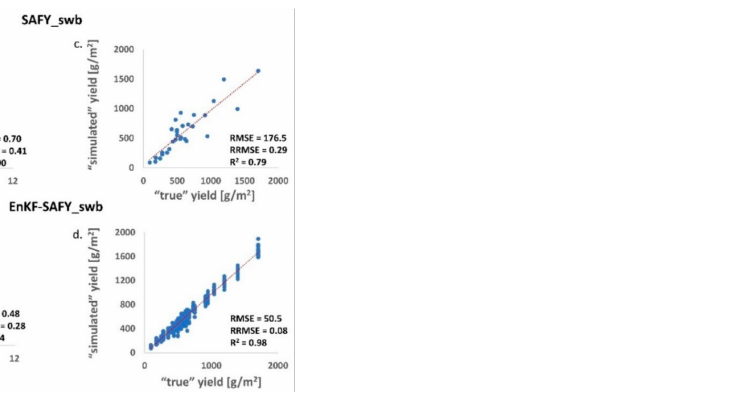
Figure 6. Comparison between “true” and “simulated” variables (generated with and without assimilation) for a synthetic dataset (generated following the procedure described in Section 2.2. ( a ) Comparison and linear regression between “true” LAI and “simulated” LAI generated with- out assimilation (using the SAFY_swb crop growth model); ( b ) comparison and linear regression between “true” LAI and “simulated” LAI generated with assimilation (using the methodology EnKF-SAFY_swb); ( c ) comparison and linear regression between “true” yield and “simulated” yield generated without assimilation (SAFY_swb); ( d ) comparison and linear regression between “true” yield and “simulated” yield generated with assimilation (EnKF-SAFY_swb). For each case RMSE, relative RMSE (RRMSE) and coefficient of determination (R 2 ) are shown.